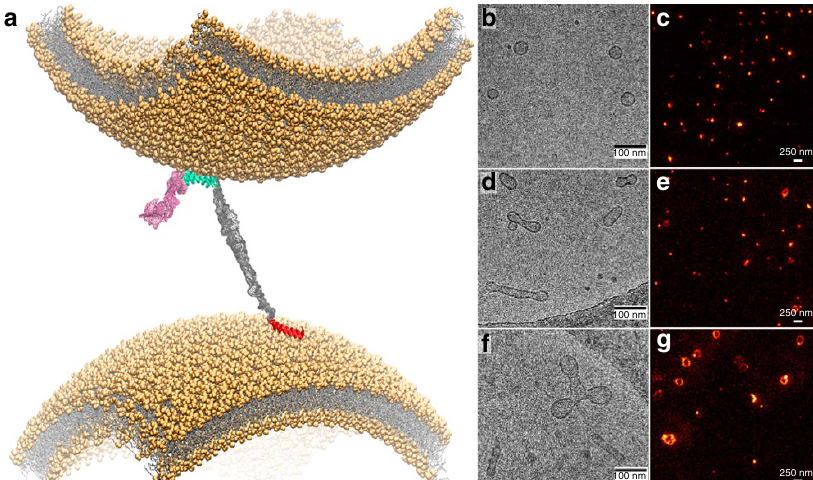
Figure 3 | Vesicle assembly induced by a S. ( a ) Molecular details of the double-anchor mechanism described in this work. SUVs of 50nm in diameter were modelled to mimic as closely as possible the experimental conditions in this study (see Methods section). a S was modelled with the N-terminal anchor in an amphipathic a -helical conformation (red) and bound to the lower vesicle. The region 65–97 (cyan) of a S was modelled in an amphipathic a -helical conformation bound to the upper vesicle. The C-terminal fragment (residues 98–140) and the linker region 26–59 are shown in pink and grey colours, respectively. With this topology the modelling reveals that a single a S molecule could simultaneously bind two vesicles that are up to 150Å apart. ( b , c ) Cryo-EM ( b ) and STED ( c ) images acquired on SUVs at a concentration of 0.5mgml (cid:2) 1 . ( d , e ) Cryo-EM ( d ) and STED ( e ) images measured on SUVs following a 12h incubation with 200 m M a S WT . ( f , g ) Cryo-EM ( f ) and STED ( g ) images acquired on SUVs following a 12h incubation with 200 m M a S Sw